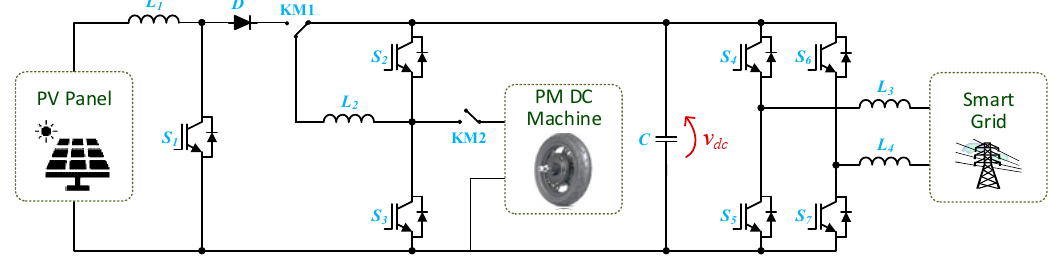
Figure 39. Unified converter topology for an electric scooter with G2V, vehicle-to-home (V2H), V2G and energy-harvesting functionalities.